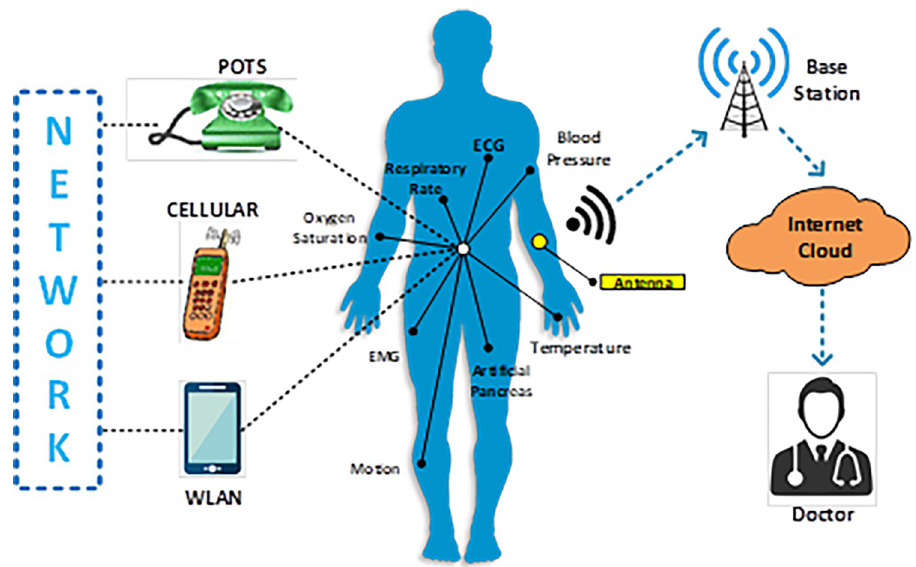
Fig 1. The implantable medical devices schematic diagram (IMDs)